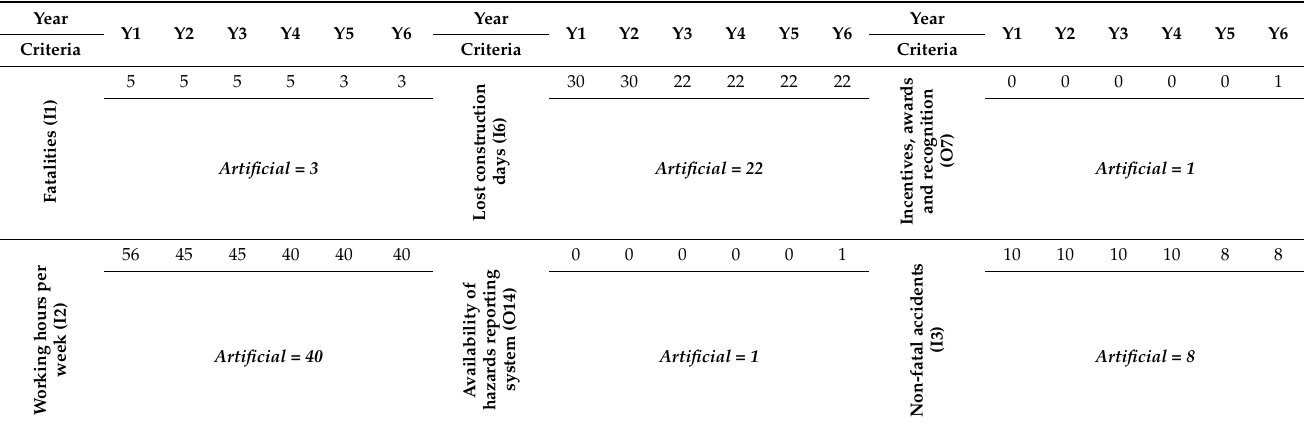
Table 4. Criteria data for the company over 6